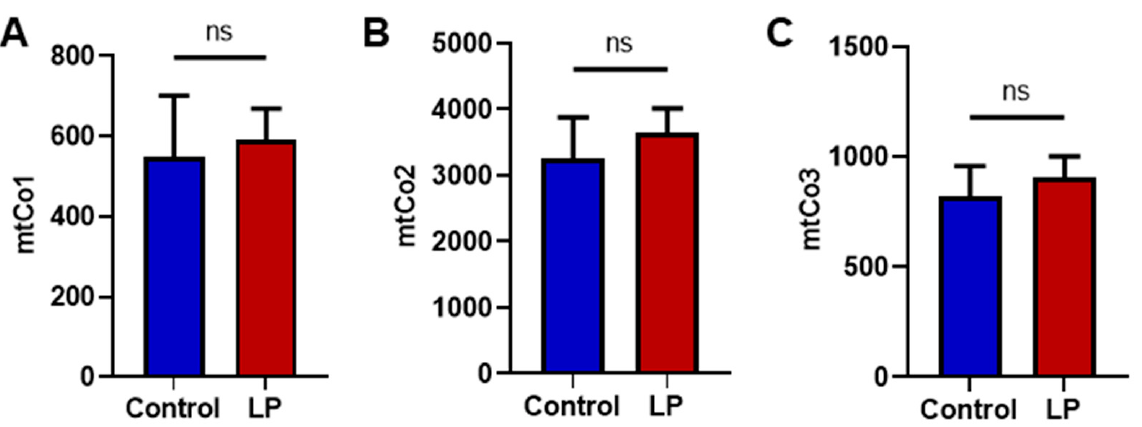
Figure 3. Effects of LP programming on mitochondrial DNA copy number in the control and LP programmed groups as quantified using qPCR. ( A ) Mitochondrially encoded Cytochrome C Oxi- dase I (mtCo1) levels; ( B ) mtCo2 levels; ( C ) mtCo3 levels when normalized to beta-actin. Data rep- resent mean ± SEM; (ns—not significant); n = 8.